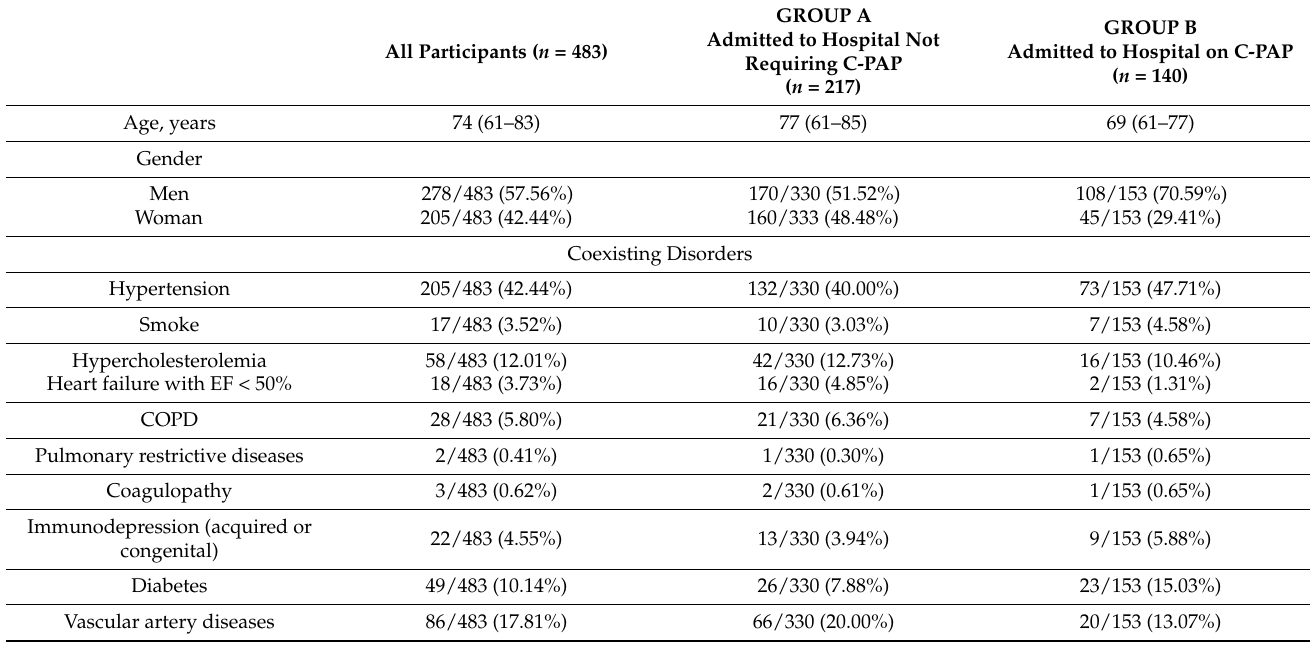
Figure 1. Flow chart of patients and oxygen strategies observed reporting enrolled patients; those discharged vs those admitted to hospital and the number of those admitted requiring oxygen mask, C-PAP and mechanical ventilation (IOT). Table 1. Characteristics of patients enrolled for the